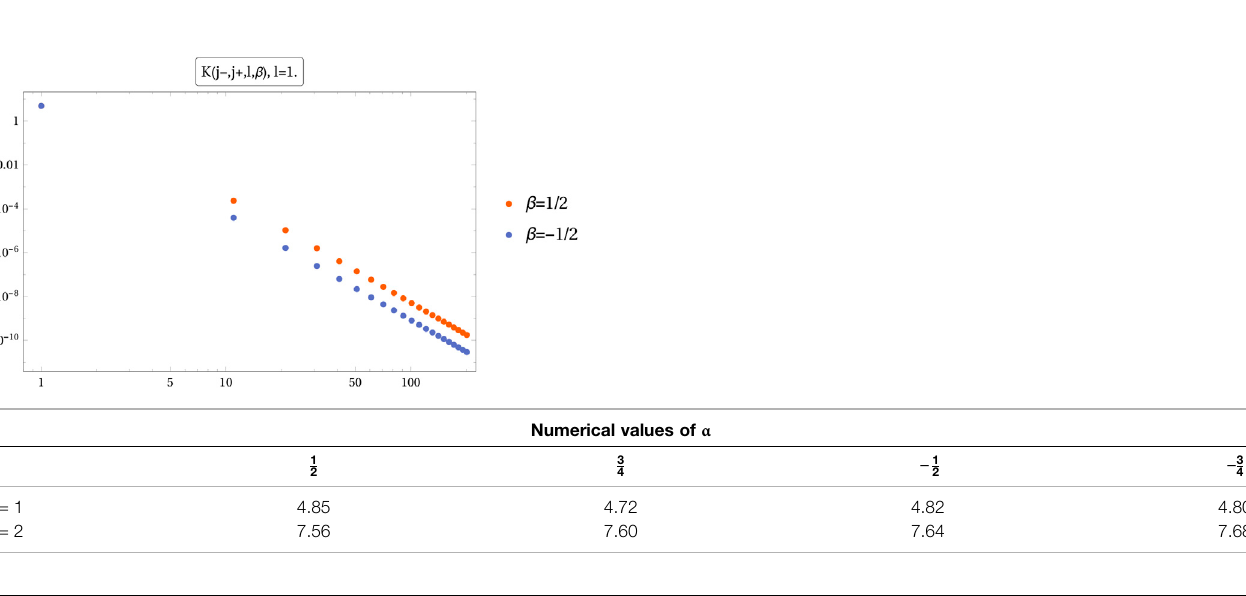
TABLE 4 | Top panel: numerical evaluation of the propagator K Duflo with l (cid:2) 1 and j − (cid:2) scaling exponent α for various values of β and l .